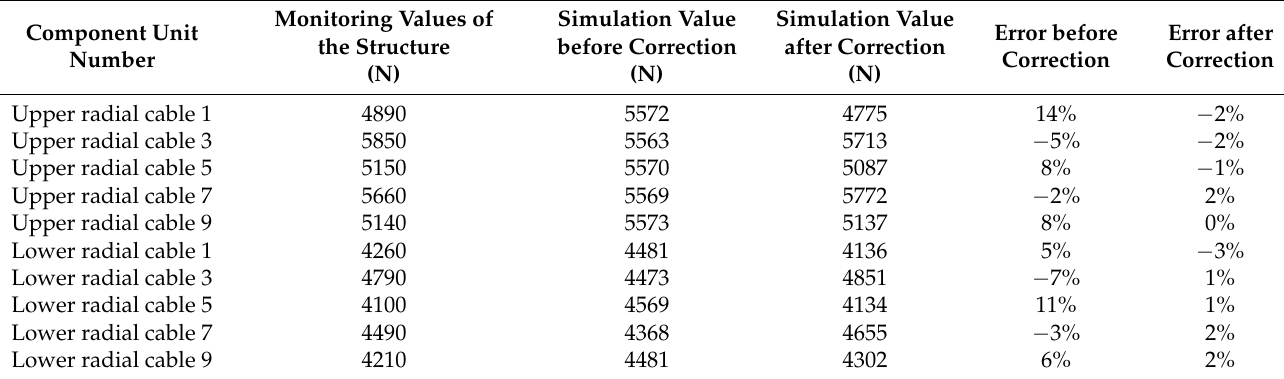
Table 2. Comparison of simulation degree of cable force before and after model